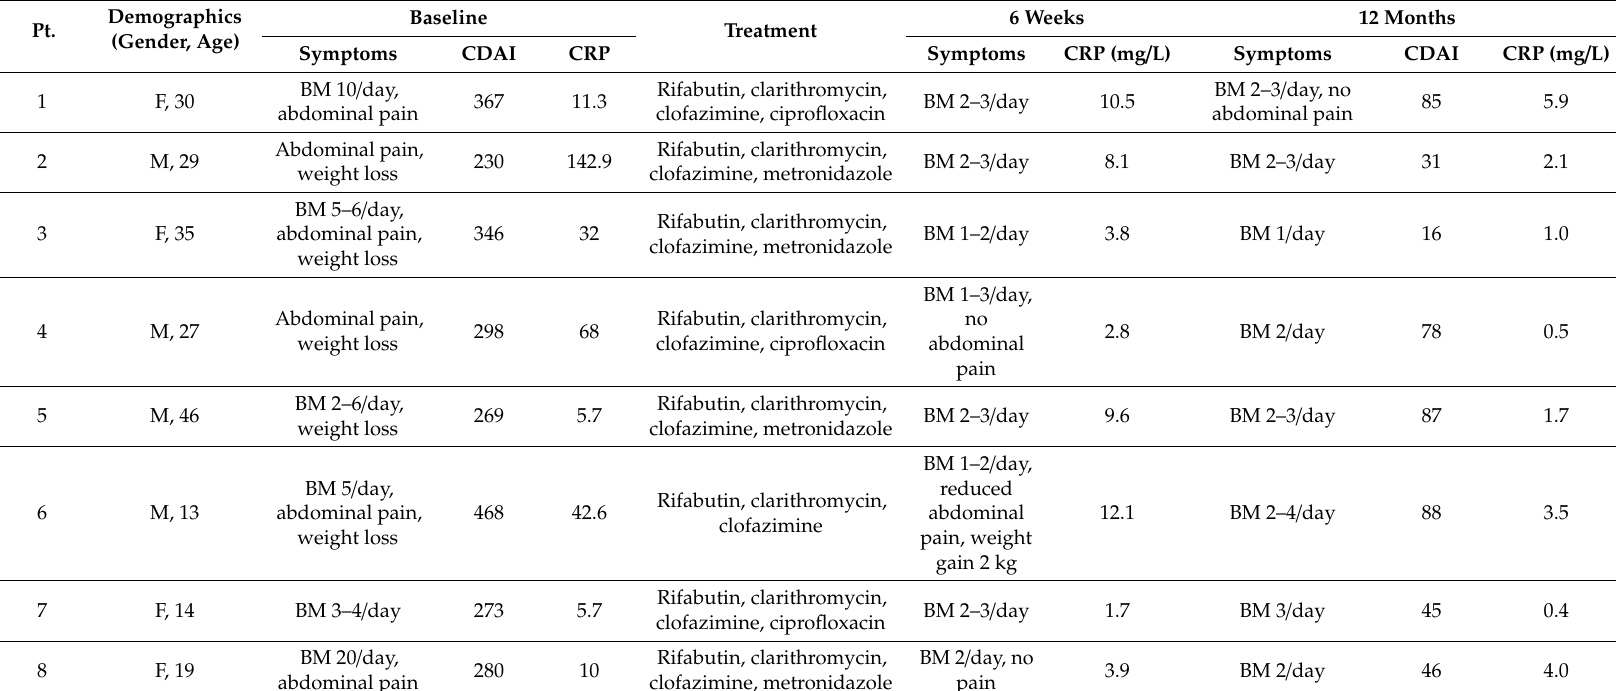
Table 1. Summary of Clinical and Biochemical Response to